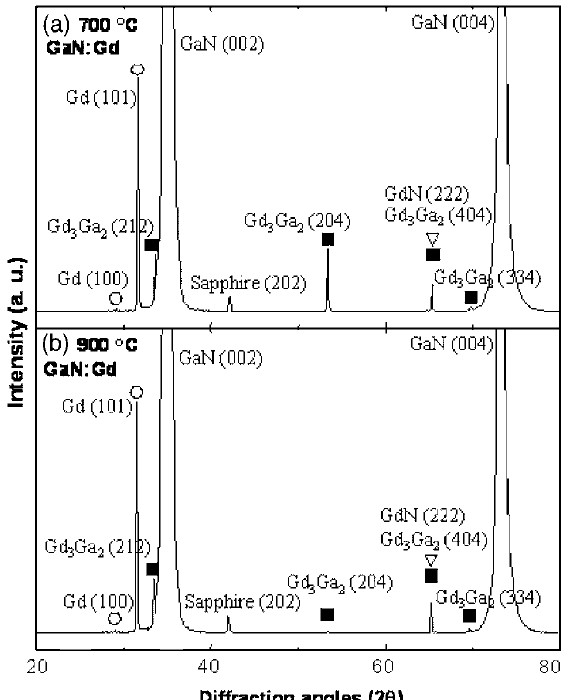
Figure 14. Secondary phases identified by XRD in Gd-implanted GaN thin layers annealed at ( a ) 700 ◦ C and ( b ) 900 ◦ C. Reproduced with permission from Reference [122].